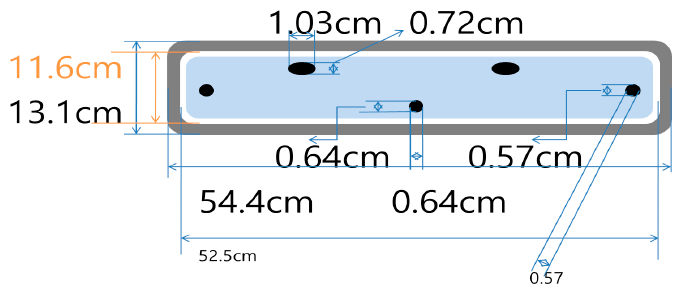
Figure 1. Size of typical license plate holder.